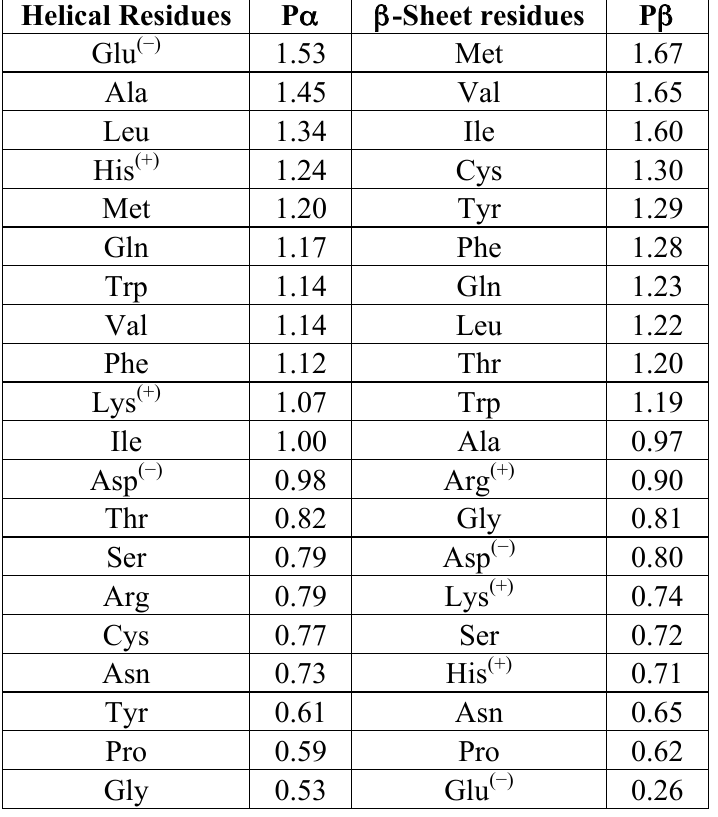
Table 1. Chou and Fasman’ conformation parameters of the 20 amino acids.